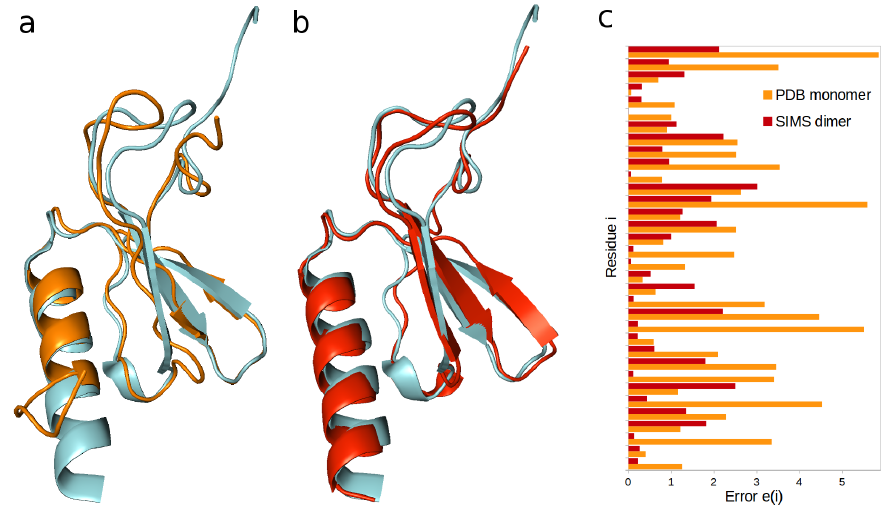
Figure 1. Reproducing the interleukin-8 (IL-8) dimer. ( a ) The conformation of the non-natural IL-8 monomer (colored orange) differs from the conformation of the monomer within the wild-type IL-8 homodimer (colored blue). ( b ) The conformation of IL-8 produced by SIMS (colored red) is very similar to that of the wild-type IL-8 (colored blue). ( c ) Differences between structurally-derived and experimental hydrogen-exchange data (unitless error e(i) , for each residue i ) are significantly lower when these data are derived from the conformation produced by SIMS (colored red) than when they are derived from the non-natural monomer’s conformation (colored